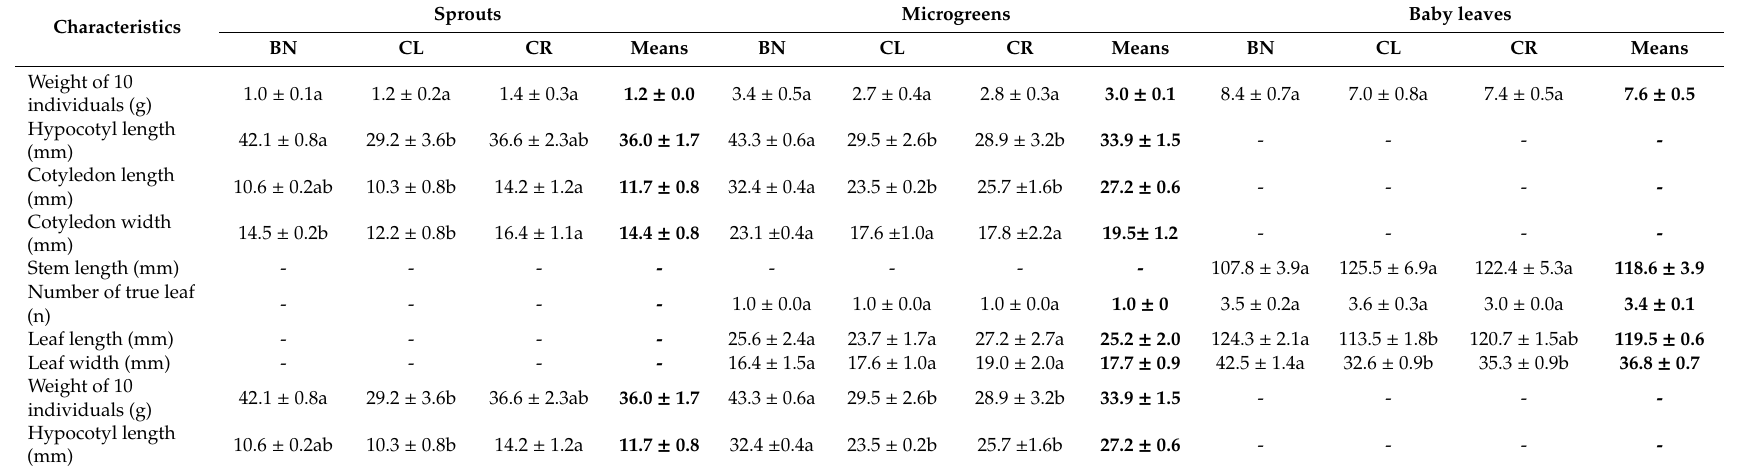
Table 3. Morpho-biometric characteristics of the sprouts, microgreens and baby leaves of the three cultivars studied. Data are reported as mean ± S.E. (n = 10).